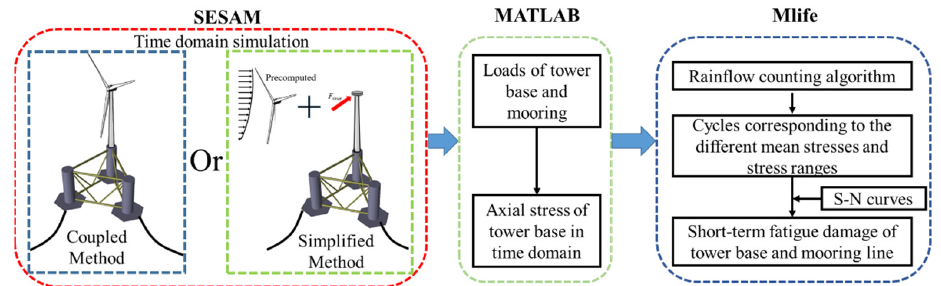
Figure 4. Procedure of fatigue damage